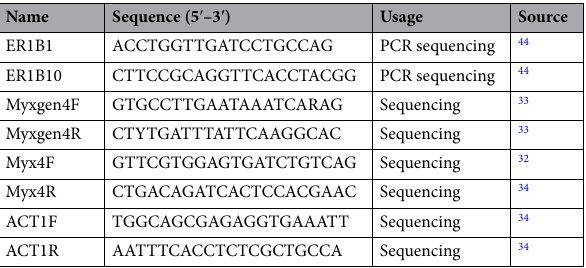
Table 3. PCR primers used for the amplification and sequencing of the 18S rRNA